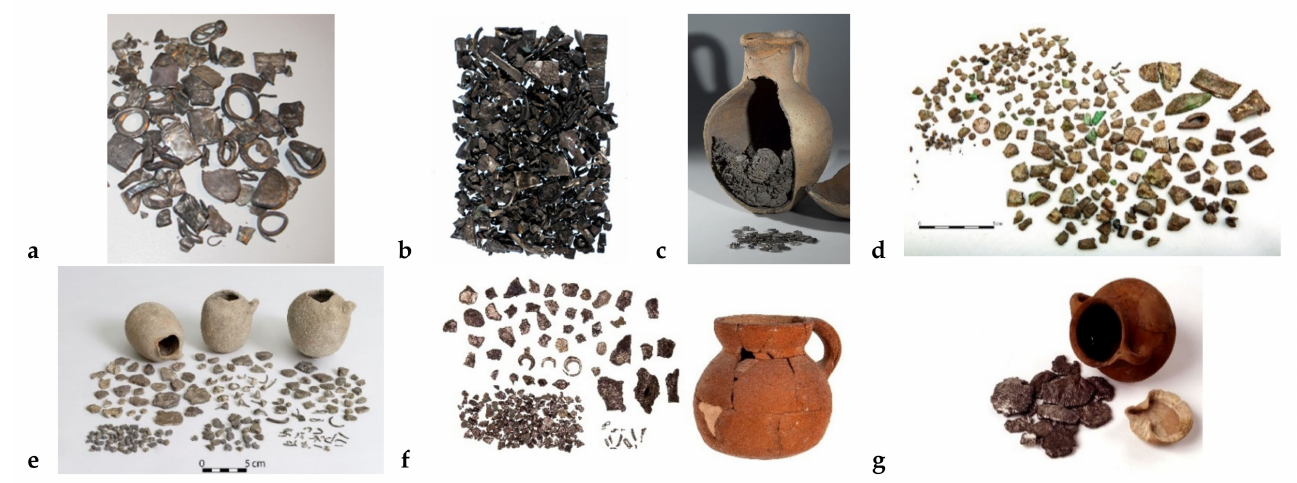
Figure 2. Silver hoards analyzed in this study: ( a ) silver from the Shiloh hoard (without pendant), courtesy of the Israel Museum, Jerusalem. ( b ) Silver from hoard Tell el-‘Ajjul 1312, courtesy of the Israel Antiquities Authority (Photo: Mariana Salzberger). ( c ) The Dor silver hoard image, © The Israel Museum by Ardon Bar-Hama (photographer) and the Tel Dor Expedition. ( d ) The ‘Akko silver hoard image courtesy of Michael Eisenberg (photographer). ( e ) The ‘Ein Hofez silver hoard image courtesy of the Israel Antiquities Authority, by Warhaftig Venezian (photographer). ( f ) The ‘Arad silver hoard, courtesy of the Institute of Archaeology, Tel Aviv University (photographed by Sasha Flit). ( g ) Selected items from ‘Ein Gedi hoard, © The Israel Museum,